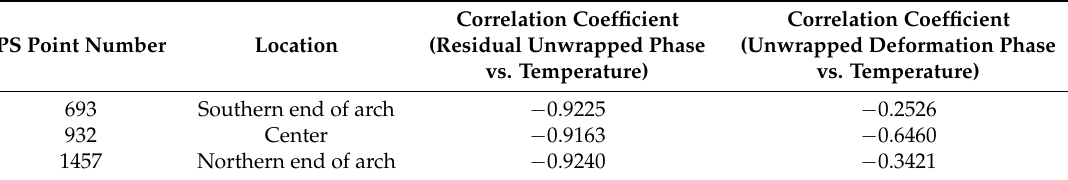
Table 4. Coefficients between the residual unwrapped phase/unwrapped deformation phase and temperature